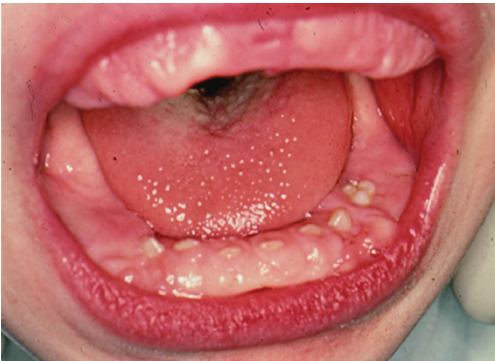
Figure 1: Pre-operative picture of gingival hyperplasia at 4 years/6 months of age.